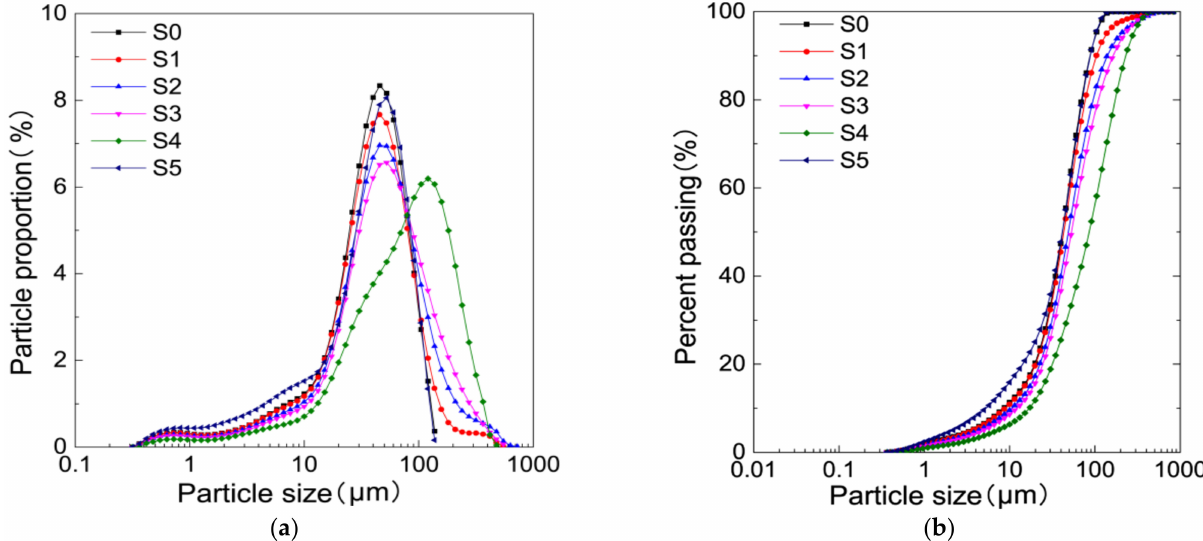
Figure 5. S0–S5 particle size characteristics of sample. ( a ) Particle size distribution curves of remolded loess samples; ( b ) cumulative particle size distribution curves of remolded loess samples.